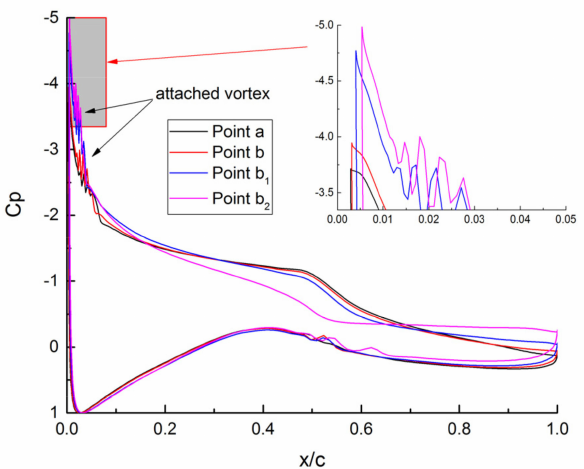
Figure 5. Pressure coefficients of four points for case